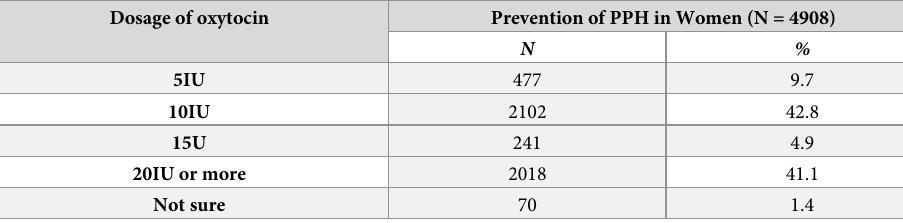
Table 5. Respondents’ dosage use of oxytocin for prevention of PPH in women.